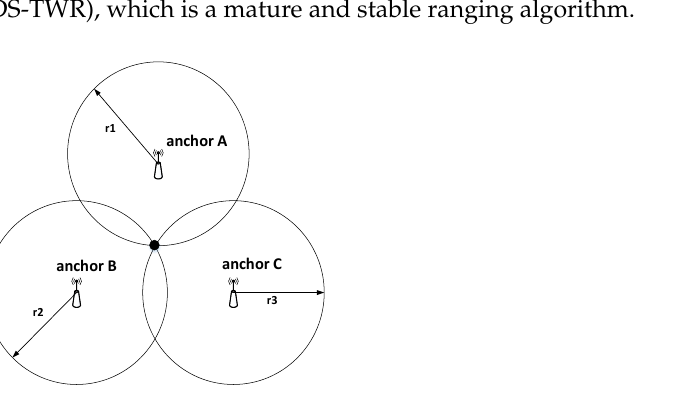
Figure A1. TOA positioning